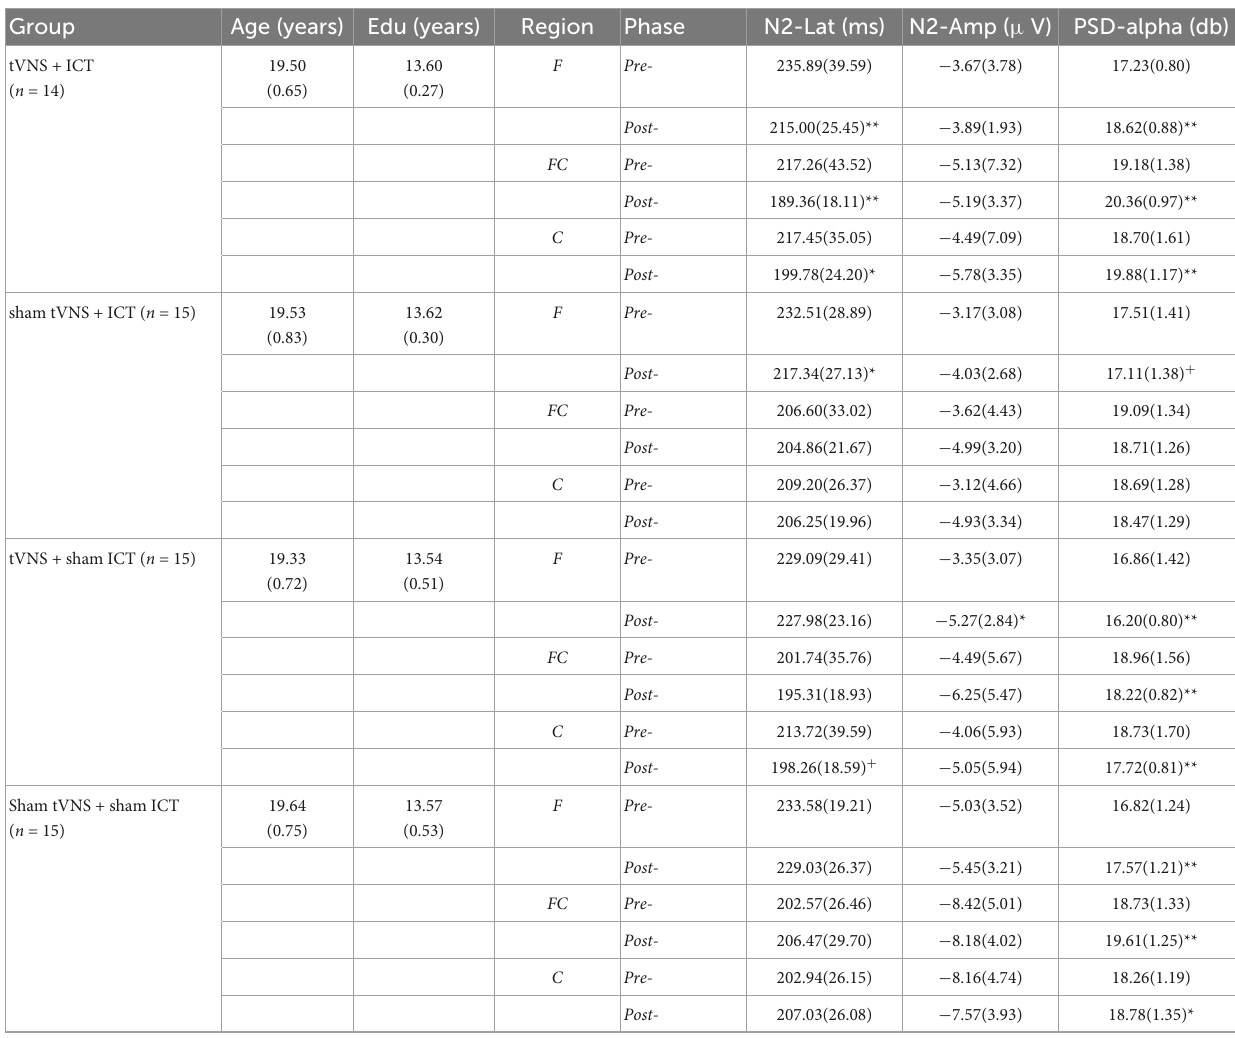
TABLE 1 Mean (standard deviation) of baseline variables including age and years of education, N2 component, and alpha power in ROIs during pre- and post-test. Group